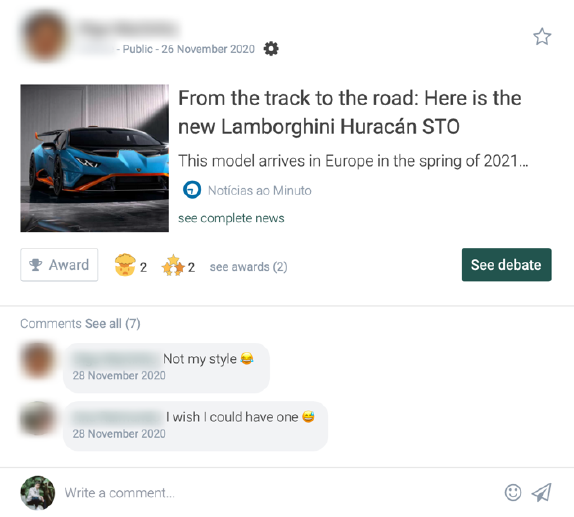
Figure 3. Award scheme on news activities (Authors’ copyright).